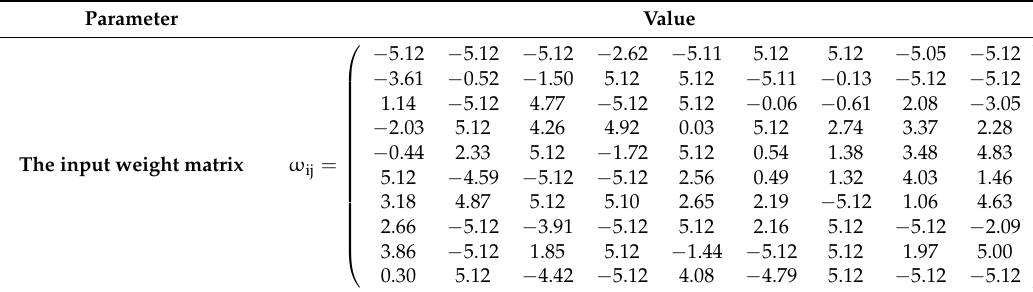
Table 6. The optimal